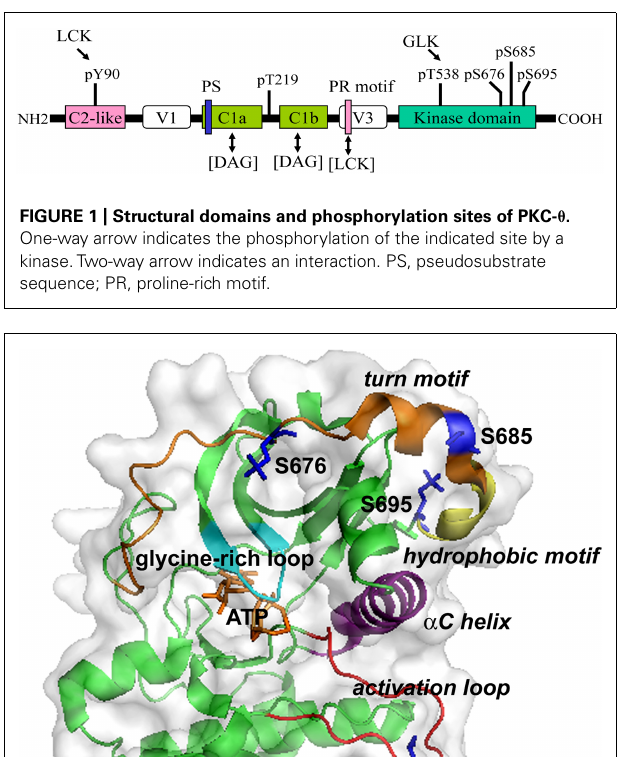
the substrate binding and phosphate delivery (Xu et al.,